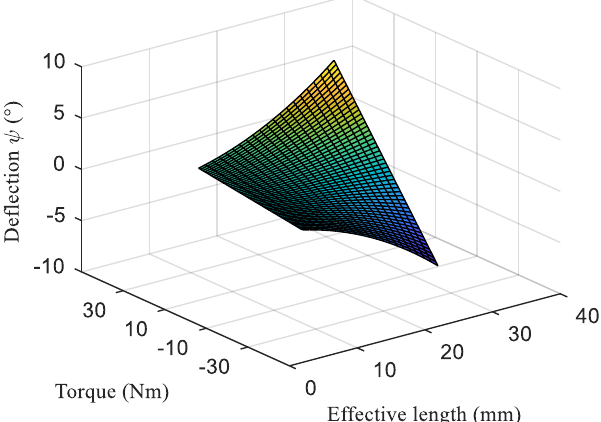
Figure 9. The relationship between the passive deflection angle and the external torque and the e ff ective